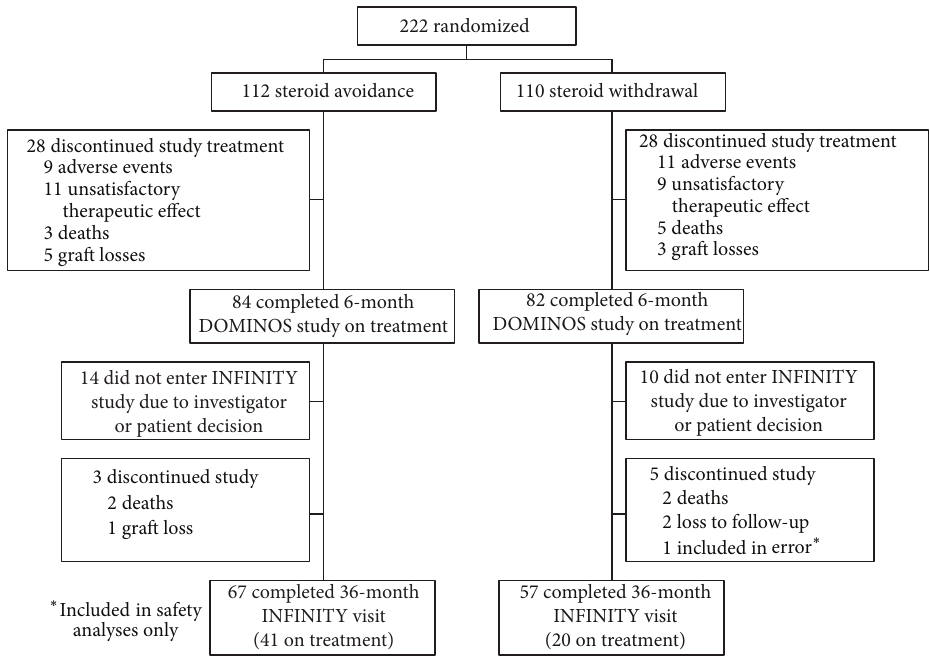
Figure 1: Patient